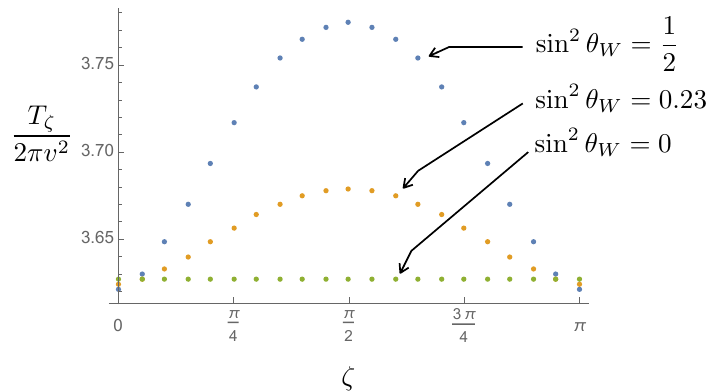
1 ; 0 : 23, and 0: W = 2 = m 1 = 125 p m Z 91 2